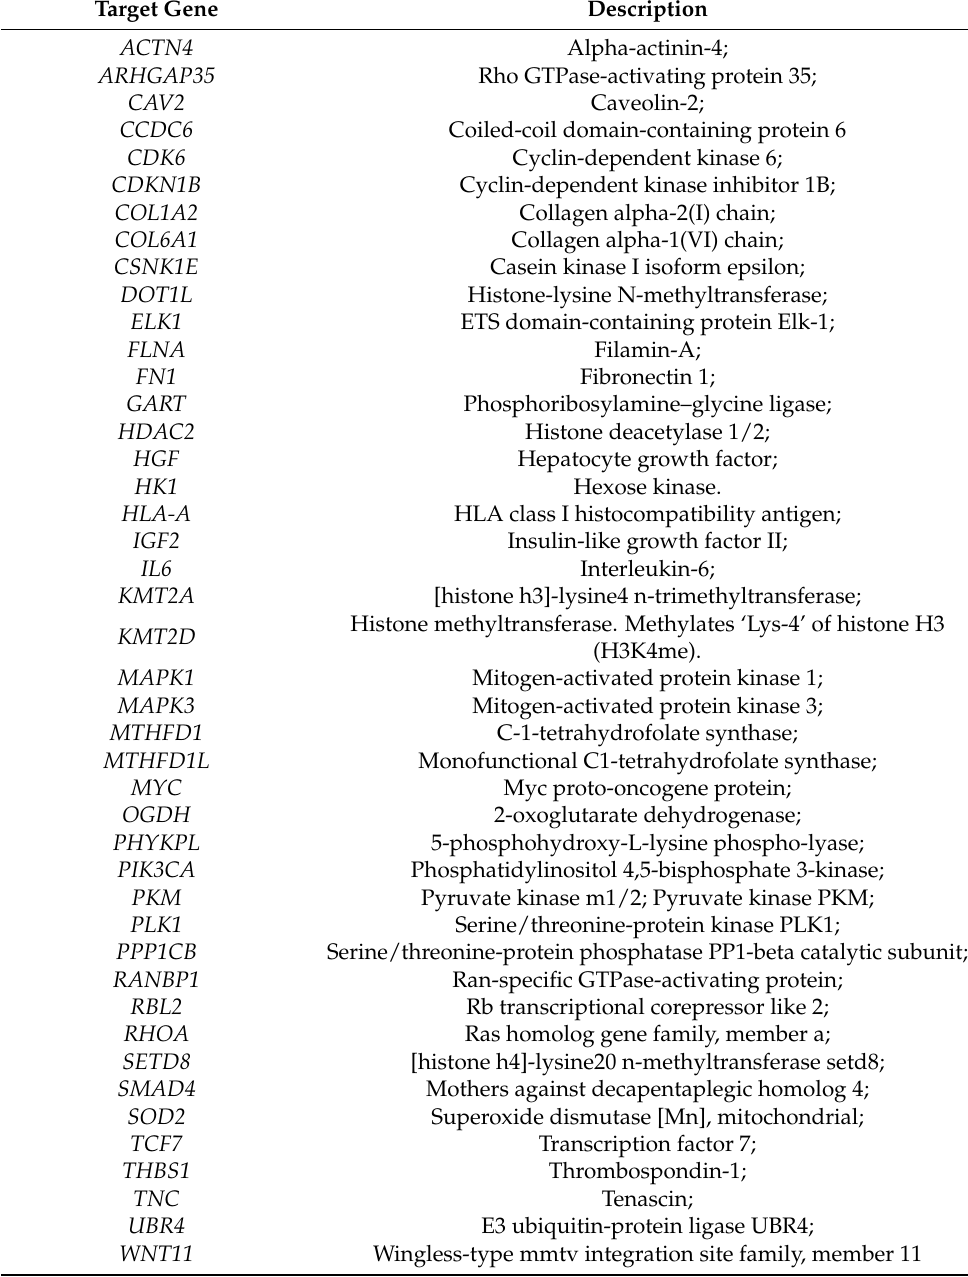
Table 2. Target genes for microRNA